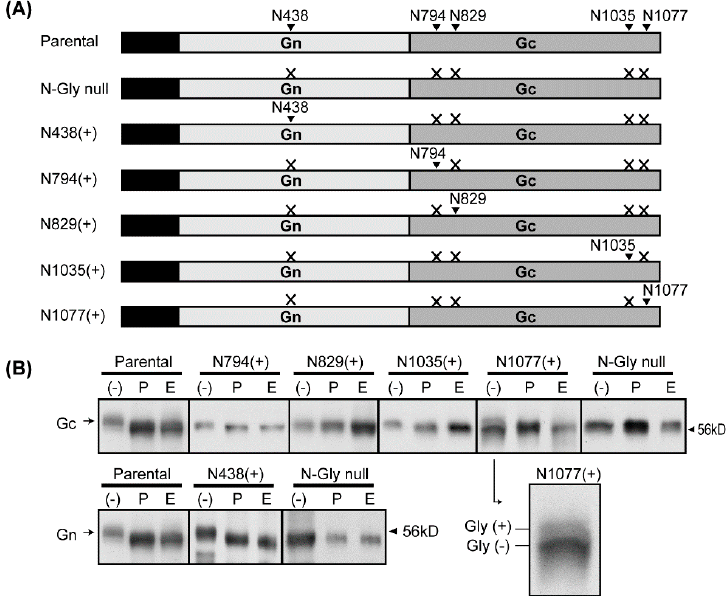
Figure 2. Mapping of N ‐ glycosylation sites for RVFV Gc. ( A ) Schematics of the Medium (M) ‐ segment